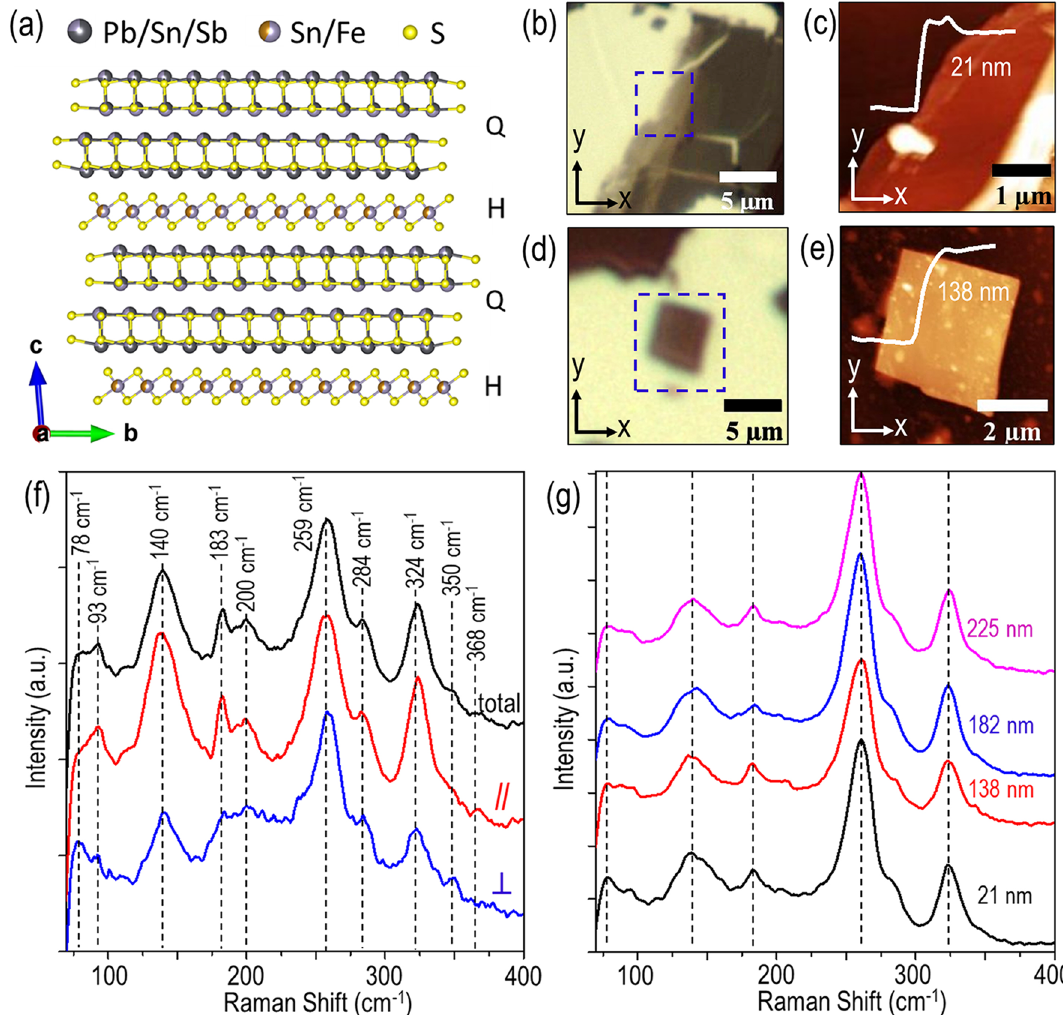
Figure 1. ( a ) Schematic side view of franckeite crystal structure. ( b , d ) Transmission microscope images of two franckeite thin flakes exfoliated on a glass substrate. Blue dashed box marks the experimentally probed region, whereas x -axis and y -axis signify the crystal’s b -axis and a -axis, respectively. ( c , e ) AFM images of the marked regions in the transmission microscope images. The line profiles in the insets signify the thickness of the probed regions. ( f ) Acquired Raman spectra from a typical exfoliated franckeite flake with 138 nm thickness in the total (black curve), parallel (red curve) and perpendicular (blue curve) polarization configurations. The corresponding Raman peaks are indicated by the black dashed lines. ( g ) Comparison of Raman spectra under the parallel configuration as a function of the franckeite flake configuration. No significant change in the Raman shift is observed, which is expected for franckeite crystal due to the incommensurate stacking of the Q-layer and H-layer 22 . However, the intensity variations in Raman modes are observed as the flake thickness changes, which can be attributed to the optical interference and the associated optical field enhancement within the layered materials 22 . Next, the angle-resolved polarized Raman spectroscopy is performed to identify the in-plane rippling direc- tion along the b -axis of franckeite crystal. Figure 2a,b show the Raman intensity contour maps depending on the linear polarization angle of the excitation beam for the 138 nm-thick franckeite flake in the parallel and perpendicular configurations, which clearly shows that the Raman mode intensities are highly polarization sensitive. The periodic variations of Raman mode intensities with respect to the linear polarization angle of the excitation beam are observed. In general, the Raman mode intensity can be expressed as